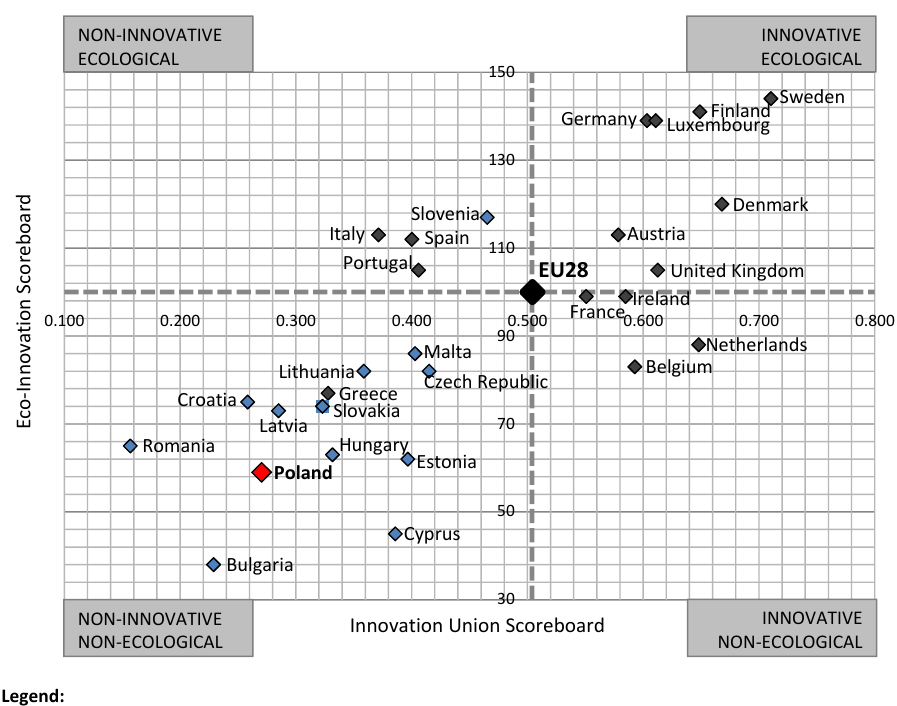
Fig. 3: Eco-innovativeness versus innovativeness in European Union Fig. 3: Eco ‐ innovativeness versus innovativeness in European Union (2017)